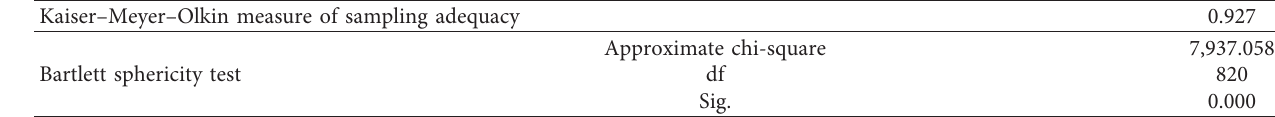
Table 3: KMO and Bartlett tests during the continuing use phase.